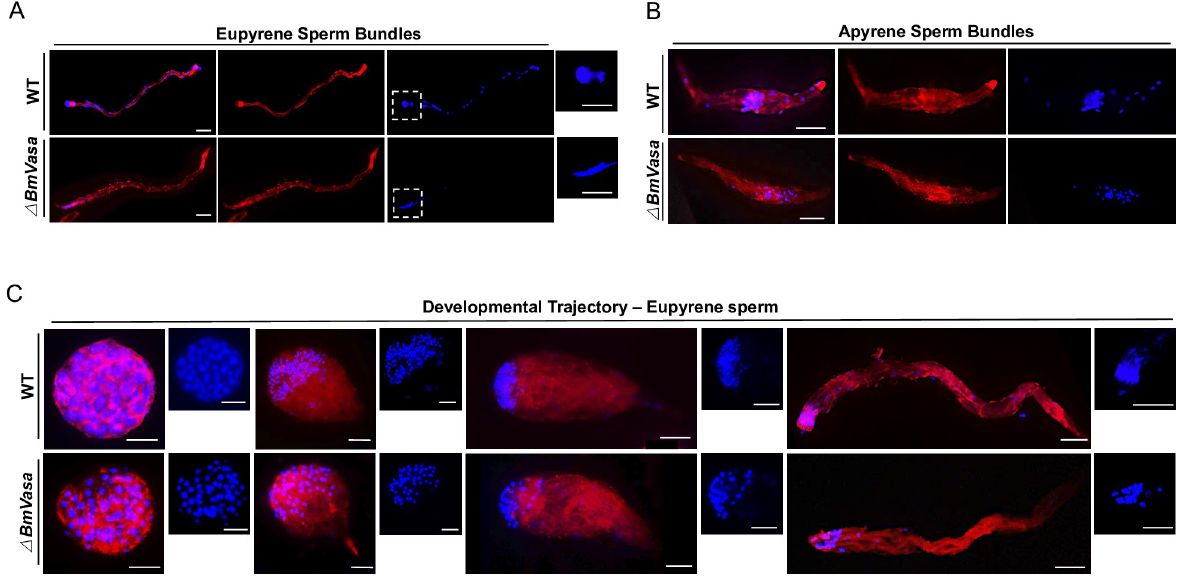
Fig 5. BmVasa mutation results in spermatogenesis defects. (A and B) Representative immunofluorescence images of A) eupyrene sperm bundles and B) apyrene sperm bundles from WT and BmVasa mutants on the seventh day of the pupal stage. Scale bars, 50 μ m. Eupyrene sperm head are highlighted in dash boxes. (C) Representative immunofluorescence images of the development trajectory of eupyrene sperm bundles at different developmental stages from WT and BmVasa mutants at day four of the fifth larval instar. Blue, Hoechst; Red, F-actin. Scale bars, 50 μ m. Δ BmVasa represents BmVasa